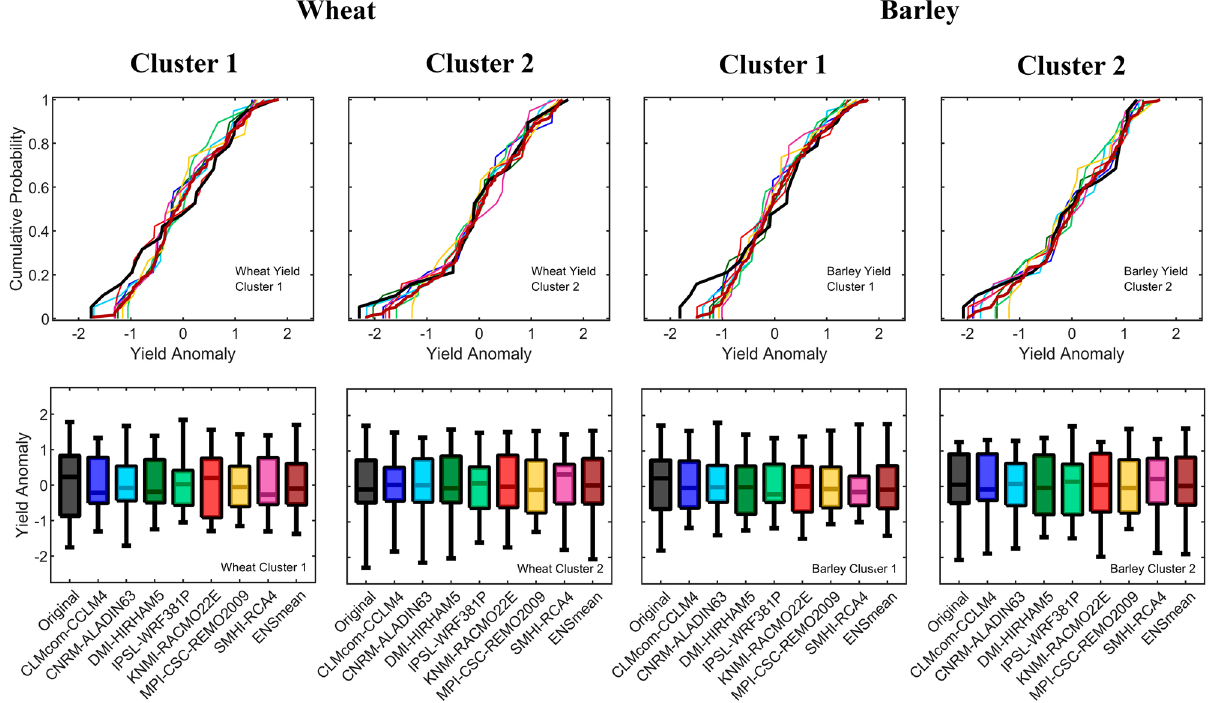
Figure 4. Comparison between distributions of yield anomaly in the form of ECDFs (top) and boxplots (bottom) for the 7 CORDEX-Evaluation models, the multi-model ensemble yield mean, and the observed values. Boxes range from the 25th to the 75th percentiles with the median depicted inside the box; whiskers represent the 1st and 99th